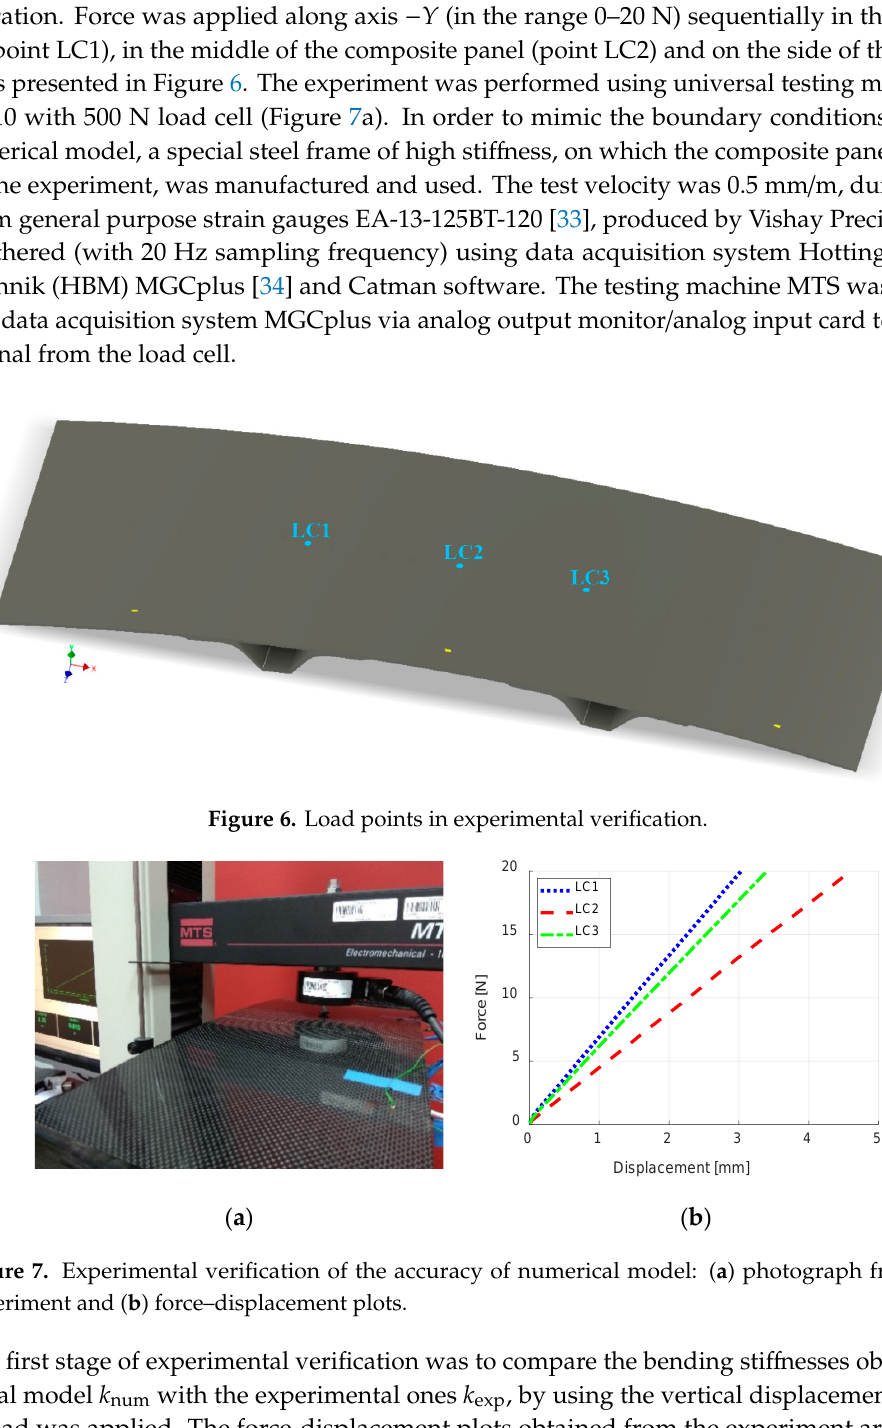
Figure 7. Experimental verification of the accuracy of numerical model: ( a ) photograph from the experiment and ( b ) force–displacement plots. Table 4. Comparison of numerical and experimental stiffnesses of the composite panel.